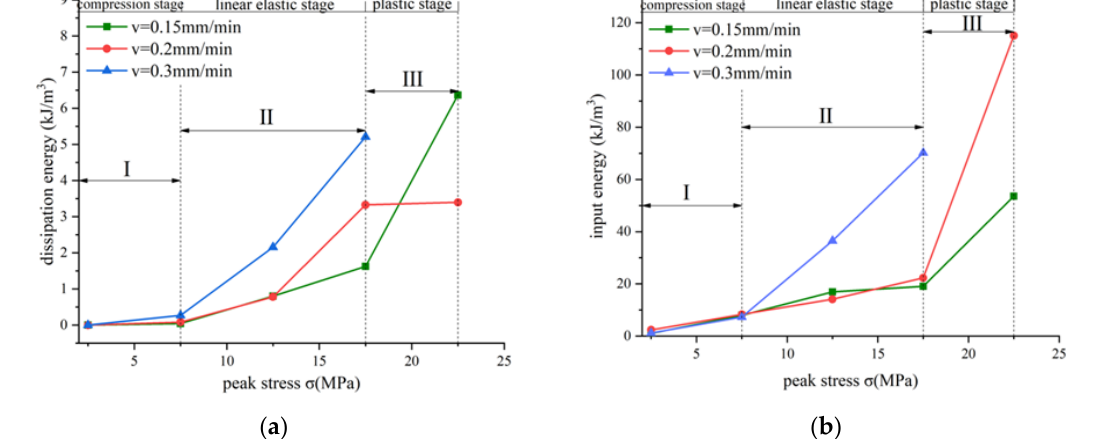
Figure 10. Change process of dissipation energy and input energy at different loading rates. ( a ) Dissipation energy (I: stable increase, II: accelerated increase, III: different degrees of increase); and ( b ) input energy (I: stable increase, II: approximate linear increase, III: large increase).